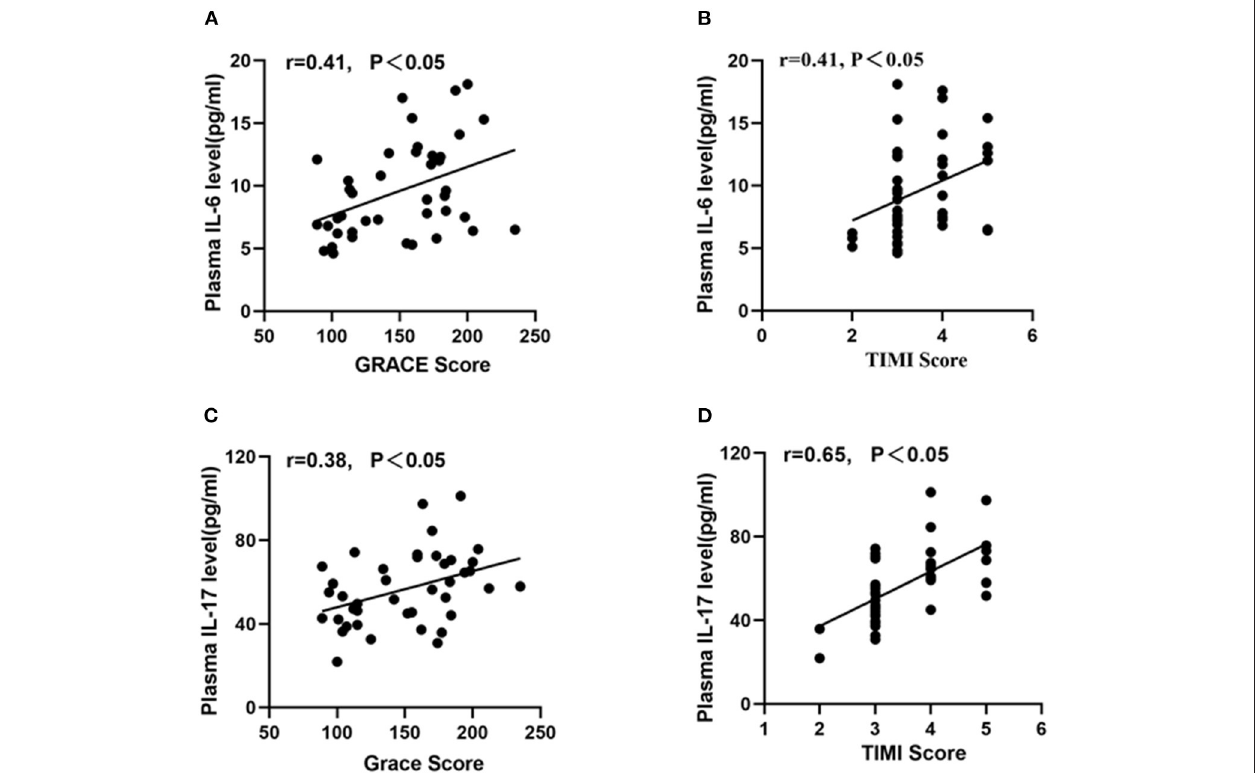
FIGURE 5 | Correlation between inflammatory cytokines and GRACE or TIMI score. Both IL-6 (A,B) and IL-17 (C,D) were positively correlated with GRACE score and TIMI score.